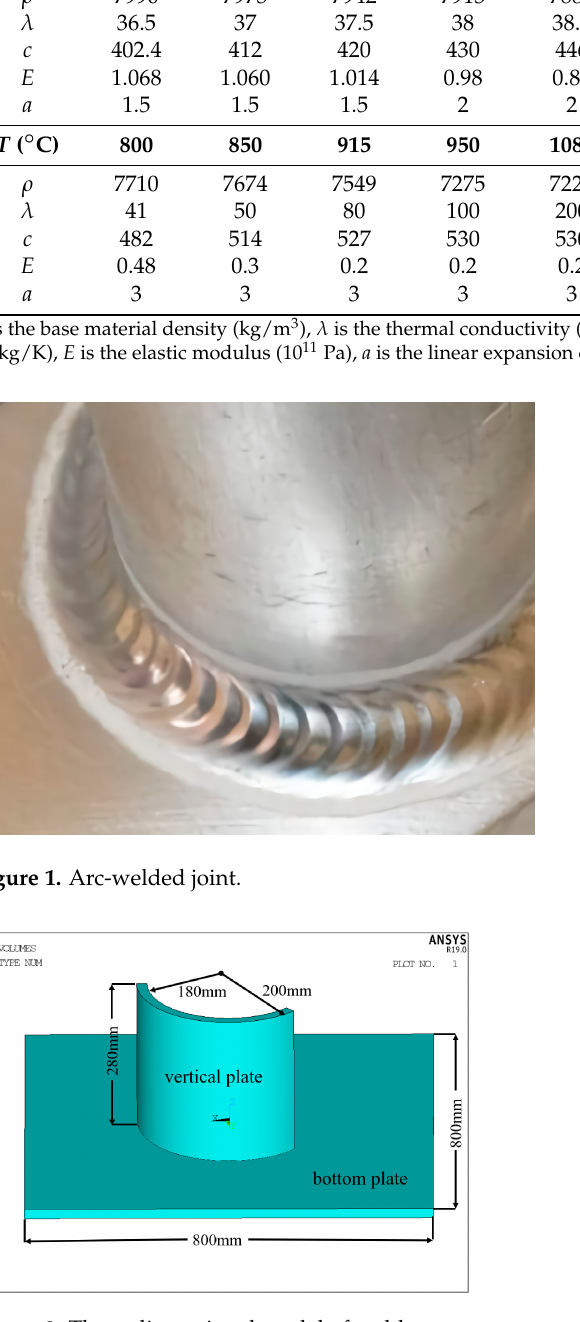
Figure 2. Three-dimensional model of